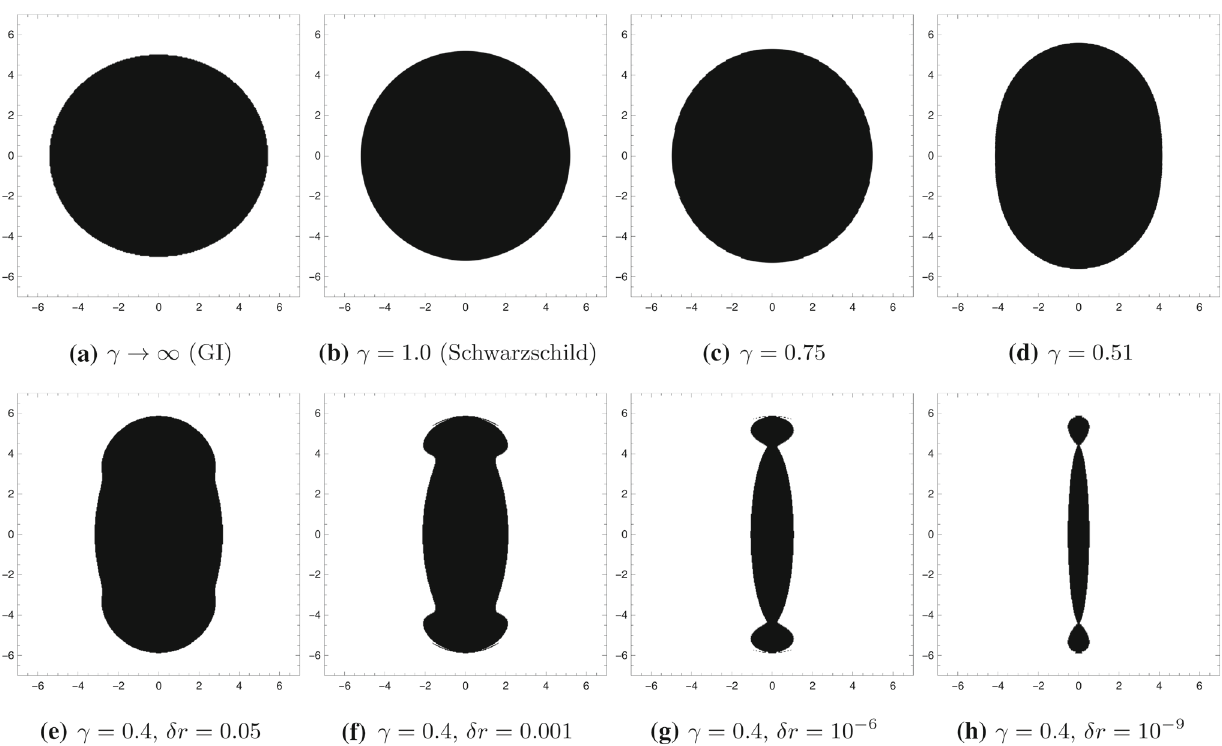
Fig. 3 Ray-traced shadows of the γ -metric. The black region will disappear for γ < 1 / 2 in the limit δ r → 0, implying that there is no shadow in this case. The observer’s inclination angle is taken to be θ o = π/ 2. The shapes of the dark regions for γ = 0 . 4 are numerical artefacts, see text